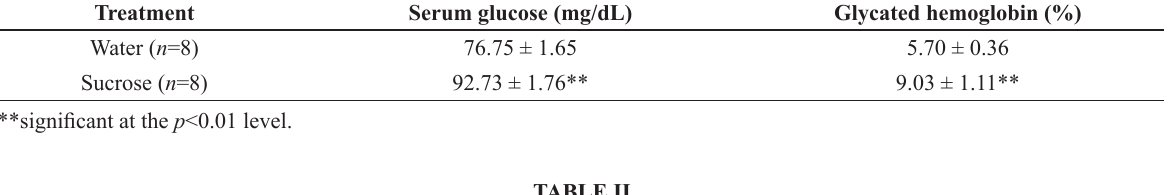
Influence of sucrose treatment on damage index in blood and hippocampus in rats. Treatment Damage Index in peripheral blood leukocytes (a.u.) Damage Index in hippocampal cells (a.u.)